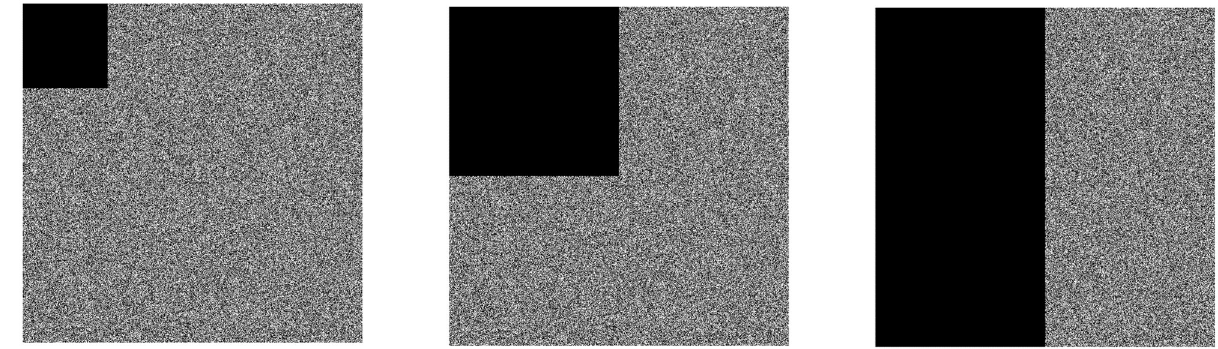
Fig 14. Encrypted image after cropping. (a) 1/16 cropped image, (b) 1/4 cropped image, (c) 1/2 cropped image.